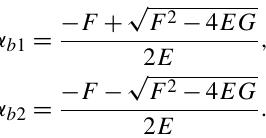
Figure 3. Example diagrams of